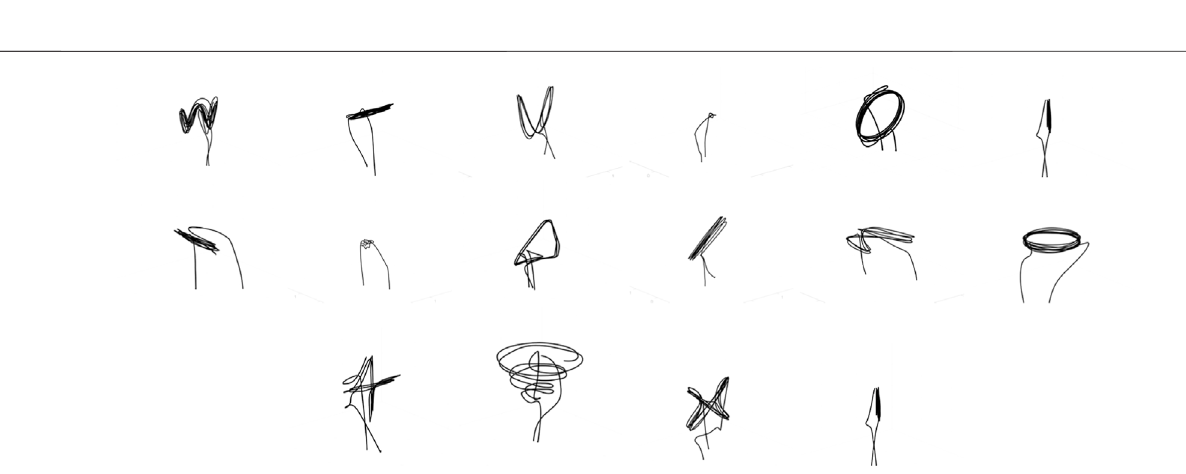
Frontiers in Robotics and AI |